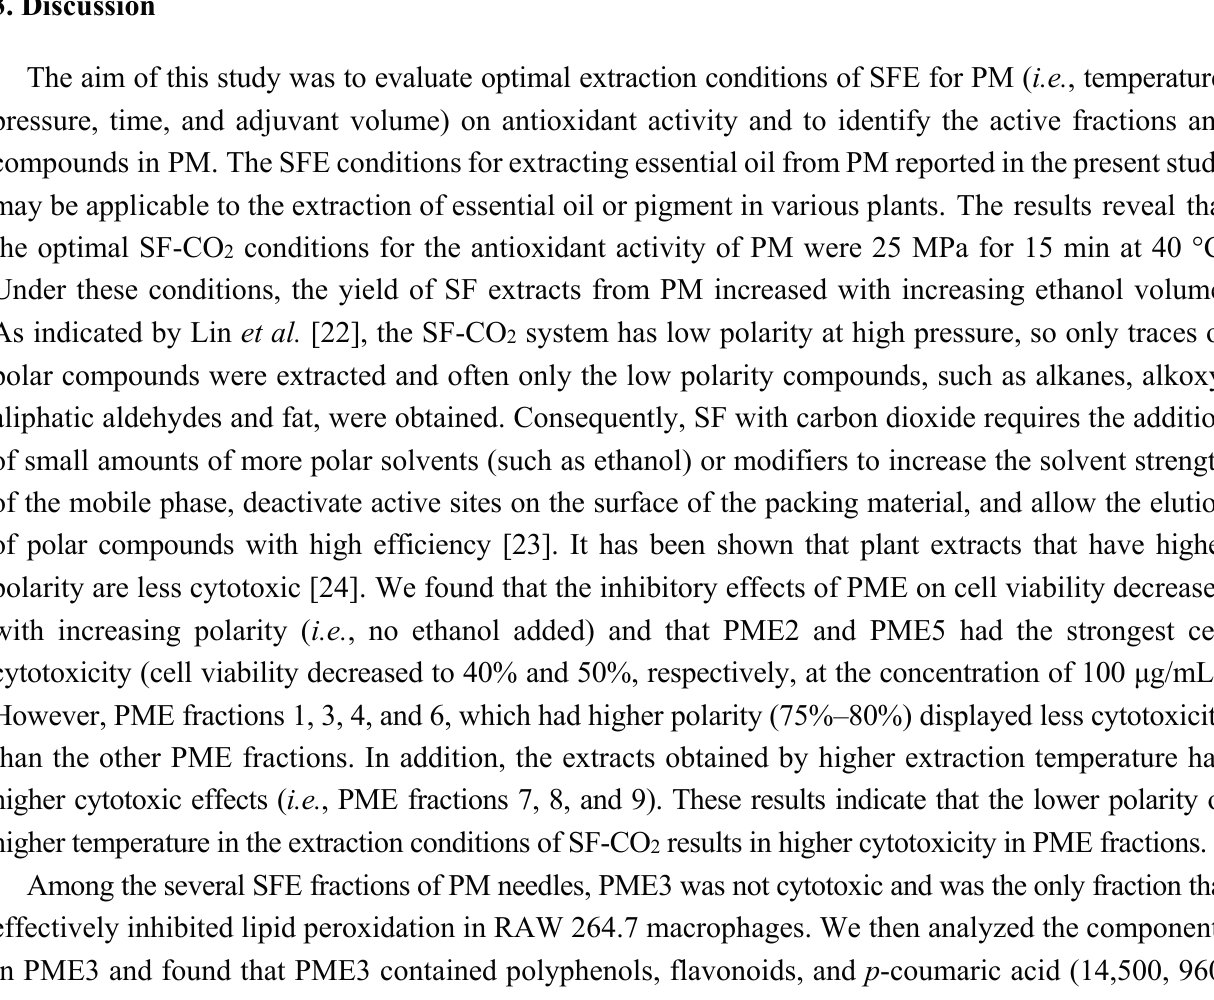
Figure 6. GC/MS analysis of hydrocarbon compounds in Pinus morrisonicola extract fraction 3 (PME3) and PME3-1. ( A ): GC/MS profile; ( B ): the constituent yield of PME3 and PME3-1. ND: not